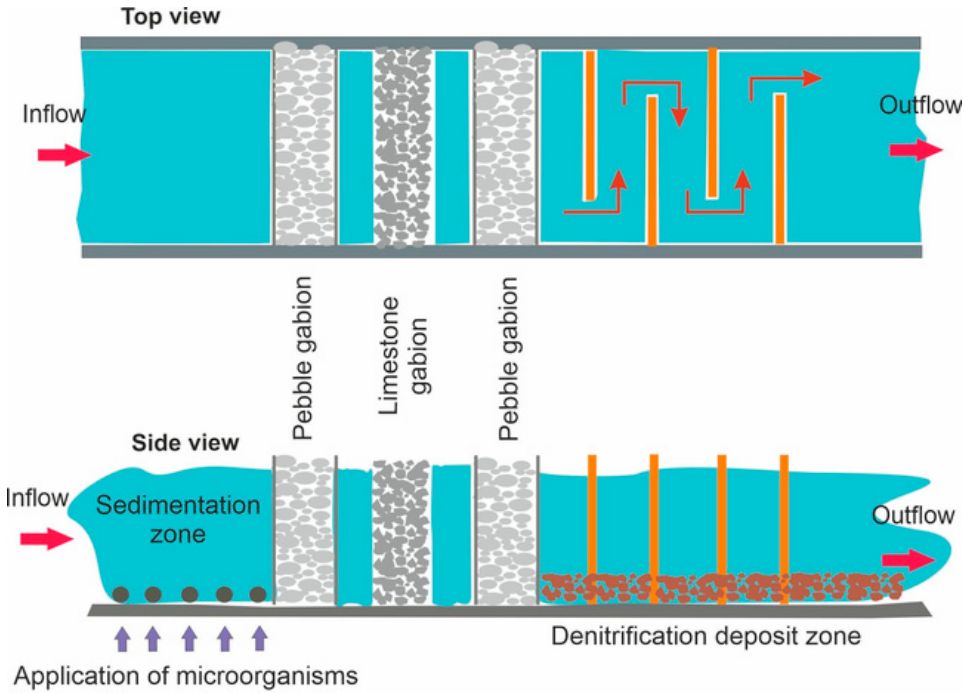
Figure 3. Overview of section B located on the Struga Gnie ź nie ń ska watercourse with the following segments: 1—sedimentation and biological activity segment—the place of application of the Micro- Dictum preparation; 2—filtration segment with stone gabions and mineral filter; 3—denitrification and slow flow segment with the applied denitrification deposit (the segments were described in detail in the beginning of Section 2.2).